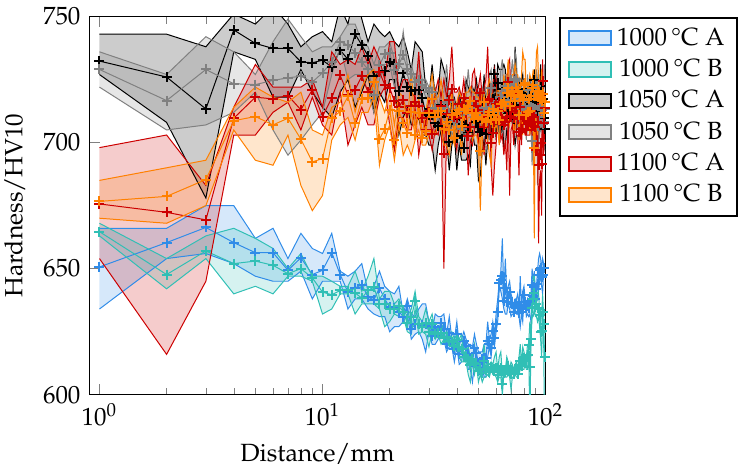
Figure 22. Experimentally determined hardness profile as a function of the distance from the quenched end face of the Jominy end quench test in HV10. Measured every 1mm indicated by marks (+). A and B indicate the respective test area of different